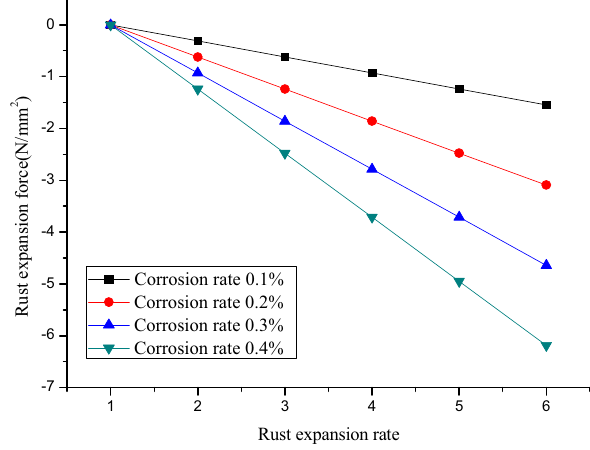
Figure 10. Relationship between rust expansion force and corrosion